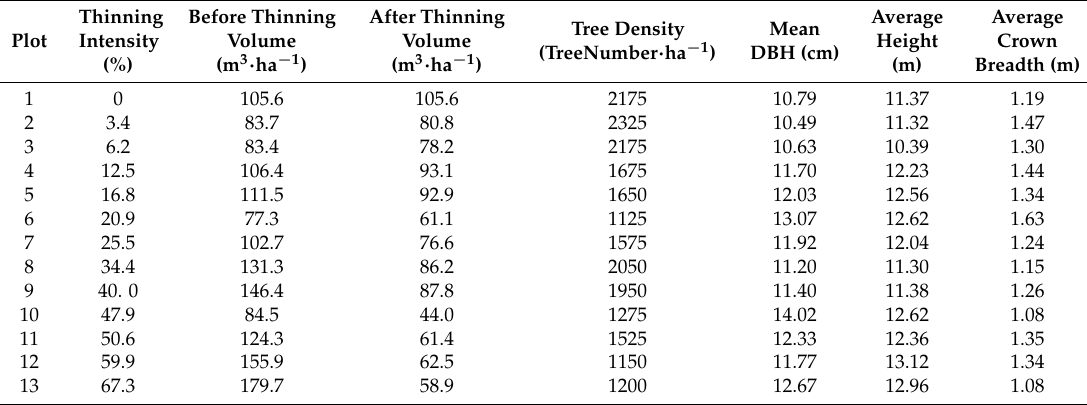
Table 1. General characteristics of the plots.